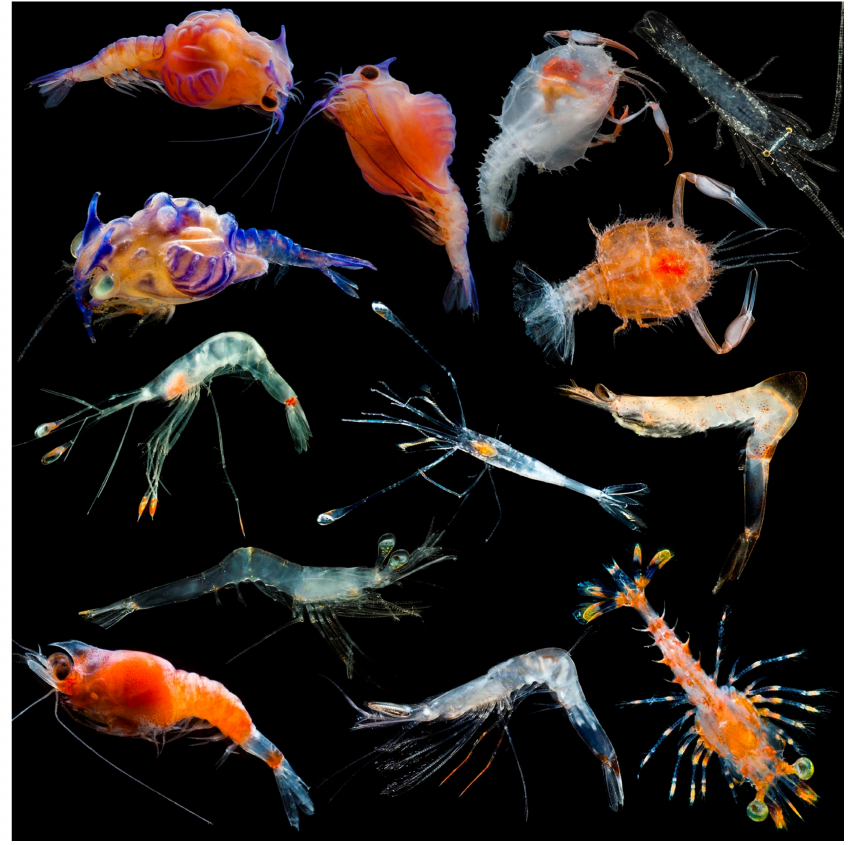
Figure 1. Examples of shrimp and lobster developmental stages collected on deep-pelagic research cruises in the northern Gulf of Mexico. ©Dant é Fenolio DEEPEND|RESTORE.